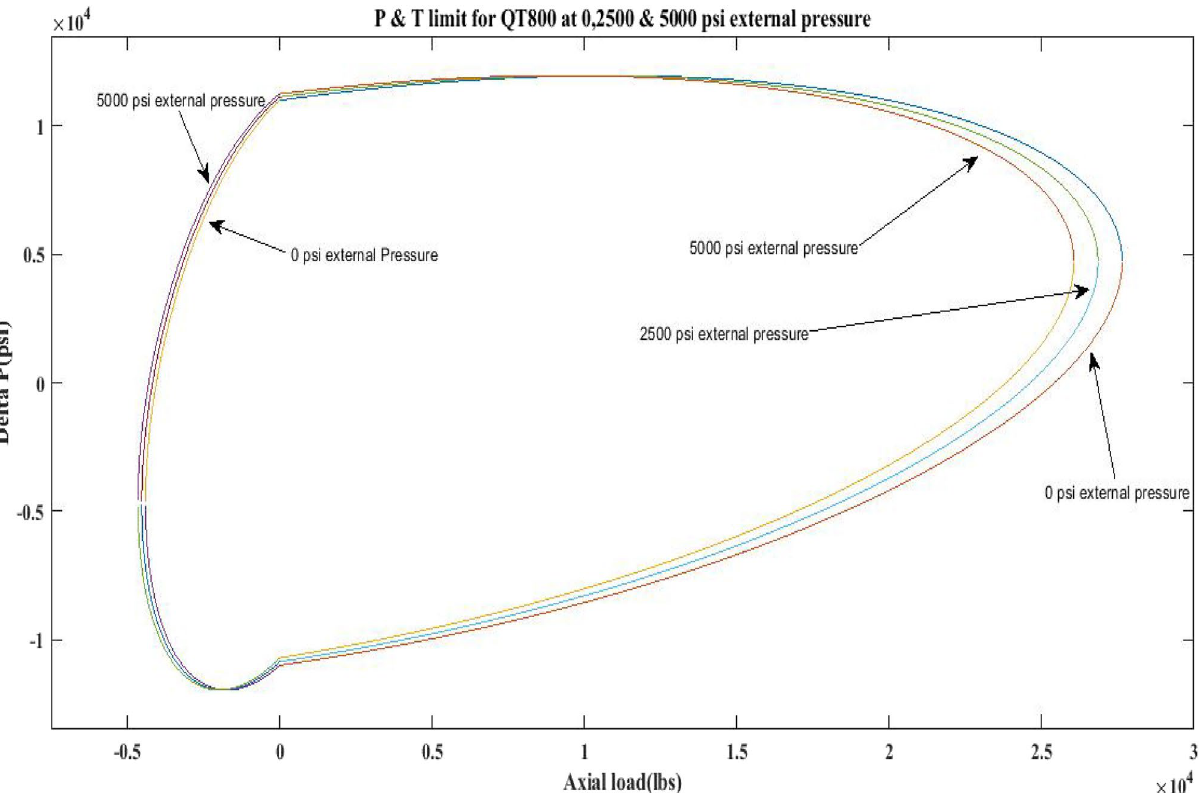
Figure 2. Limit curves for QT 800 at 0, 2500 psi, and 5000 psi external